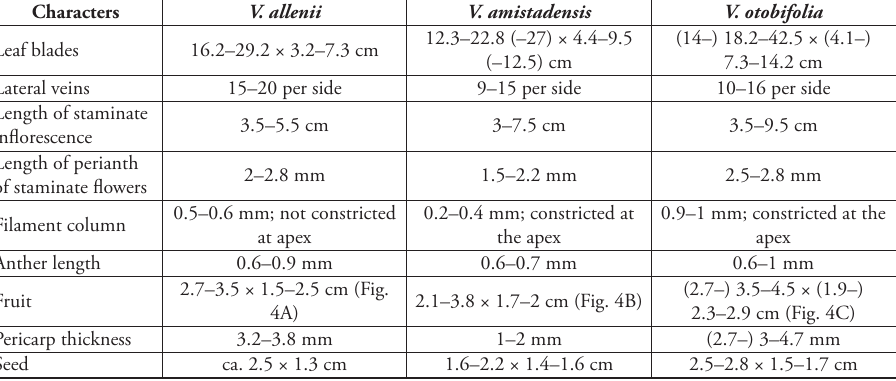
Table 3. Comparison of Virola allenii with the two other morphologically most similar species in